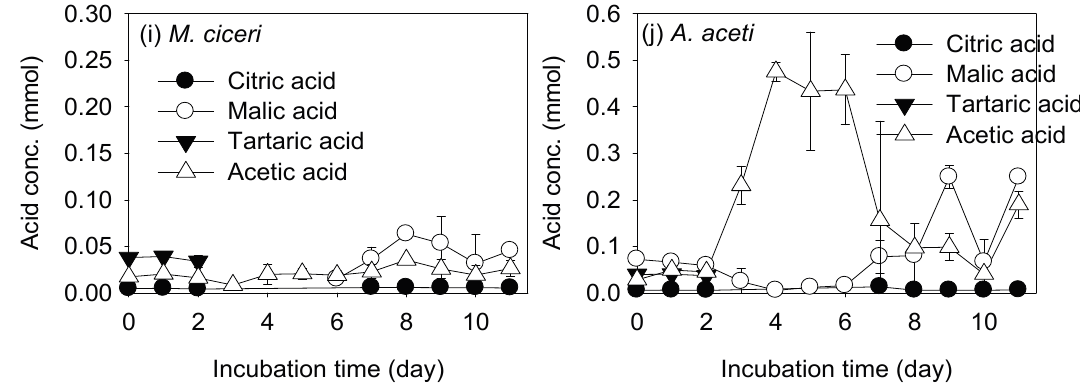
Figure 2. Organic acid production of ( a ) P. rhizosphaerae DSM 16299 T , ( b ) P. fluorescens